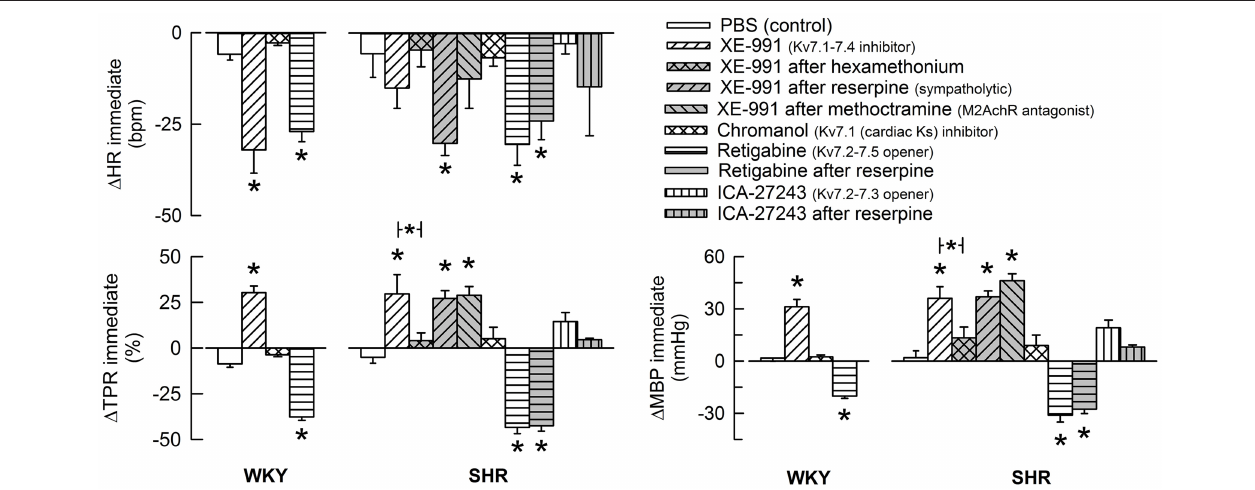
FIGURE 2 | The acute HR-, TPR-, and MBP-response to K V 7-inhibitors and -openers. Preferred drug selectivity is indicated by symbol legends. The drugs were given alone or, in SHR, in combination as indicated. The immediate HR- and MBP-response was recorded at the initial TPR-peak/nadir-response. Significant changes in response to channel inhibitors/openers compared to that following the sham-injection of PBS in the control groups were detected as indicated (asterix below/above columns). Involvement of ganglion transmission, sympathetic nerve norepinephrine release and M2AchR activity in the response to Kv-drug was further analyzed in SHR by prior administration of hexamethonium, reserpine or methoctramine, respectively (* in bar). * above columns— P ≤ 0.0167 in WKY and 0.0056 in SHR. * in brackets— P ≤ 0.0167 for XE-991 (none detected) and 0.025 for retigabine.